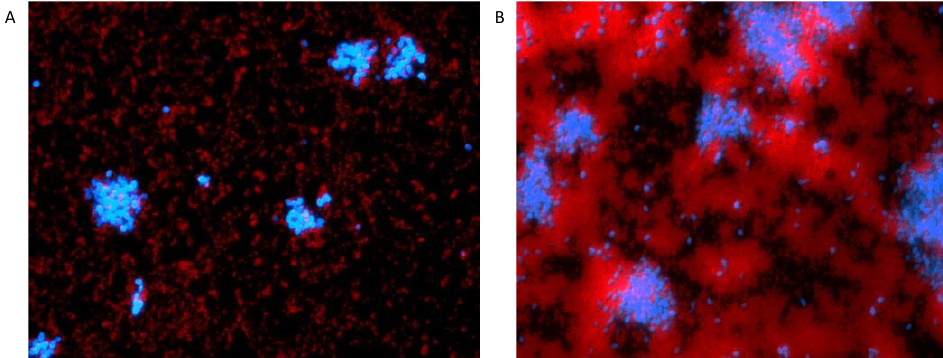
Figure 2. Development of a Candida auris dual-species biofilm. Images captured of 24 h dual-species biofilms containing C. auris with S. aureus ( A ) and S. epidermidis ( B ). Biofilms were stained using 1.5 mM calcofluor white and 1.5 mM hexidium iodide for 1 h to visualise fungi (blue) and bacteria (red). Calcofluor white and hexidium iodide were fluoresced at excitation/emission wavelengths of 357/447 and 531/593 nm, respectively.